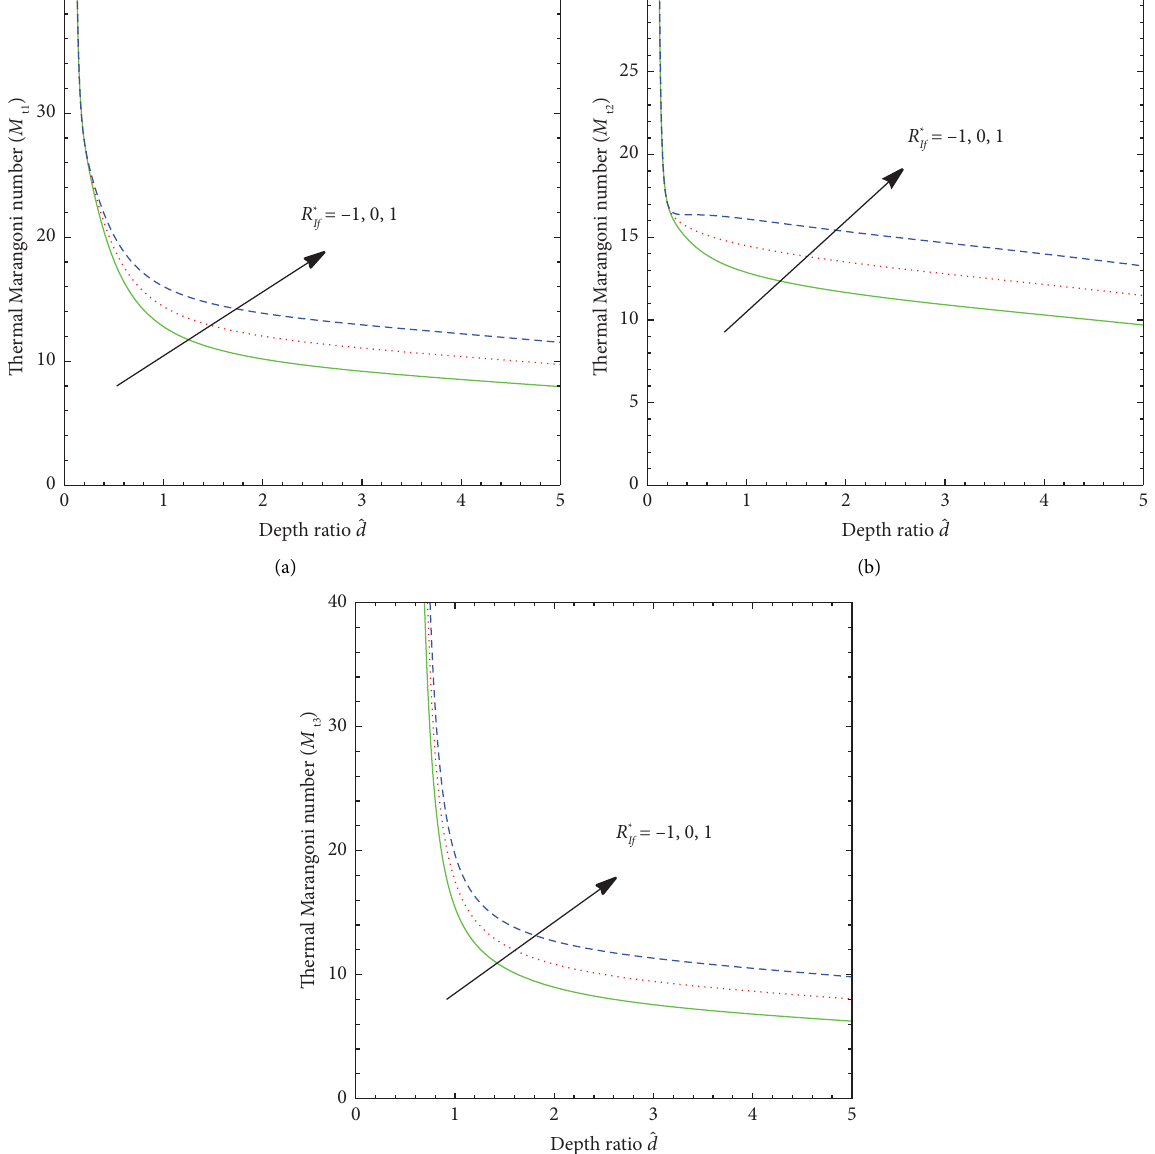
� − 1 , 0 , 1 in region-1 when a If